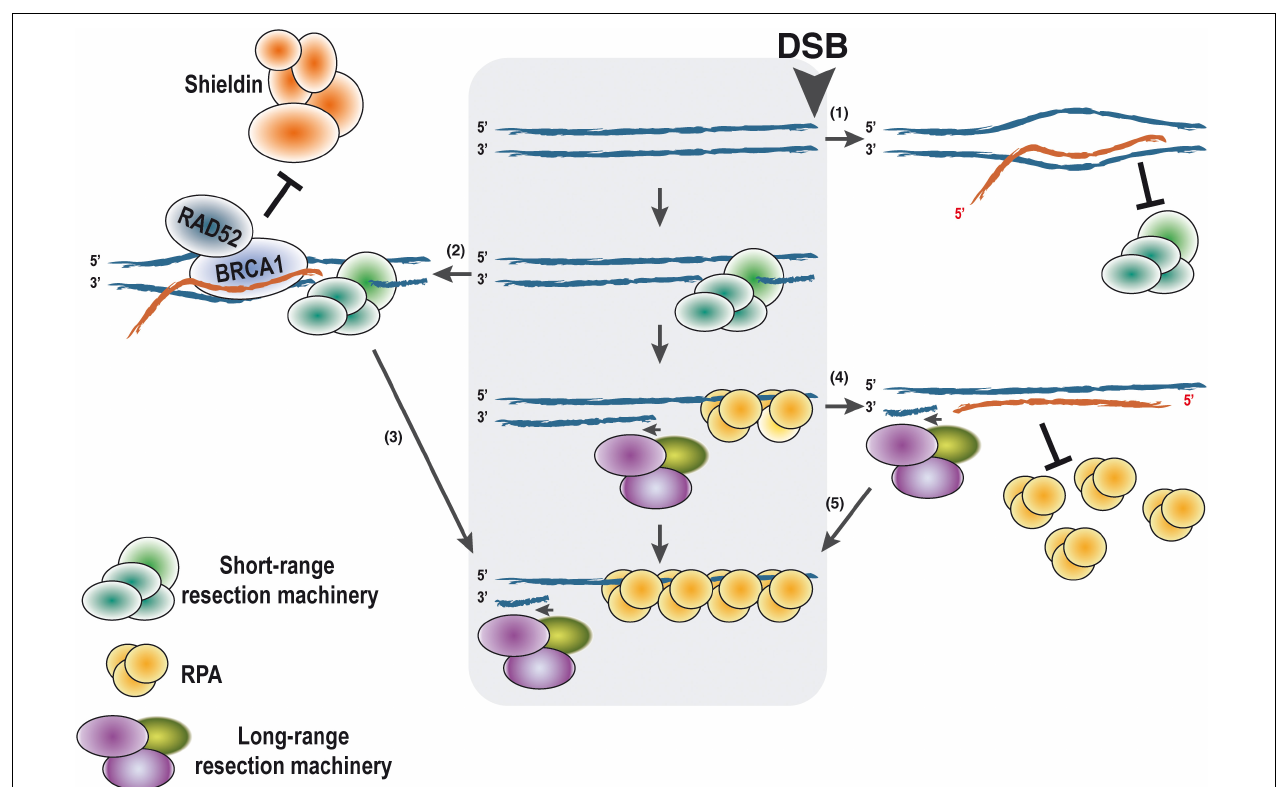
FIGURE 2 | Putative effects of DNA:RNA hybrid presence on DNA end resection according to the timing of their appearance. DNA end resection proceeds unimpaired in the absence of the DNA:RNA hybrid (central gray box). For simplicity, only one end of the DNA is shown, with the DSB on the right side as marked. When an R-loop is present at the site of the break, it might block DNA end resection by blocking the first steps of the process (1) . On the contrary, other studies indicate that if resection can indeed be started, the presence of a DNA:RNA hybrid can stimulate resection by attracting RAD52 and BRCA1 (2) . They in turn will antagonize the anti-resection function of the Shieldin complex, thus stimulating resection processivity (3) . Once resection is fully activated and the long-range resection is engaged, de novo transcription would create ncRNAs that can pair with the ssDNA, forming DNA:RNA hybrids (4) . Such hybrids will not affect resection and will facilitate a full DDR. The presence of such structures might block RPA loading. Thus, elimination of the RNA will be required for activation of homologous recombination and limit DNA end resection (5) . In all cases, the polarity of the DNA and RNA is shown. DDR, DNA damage